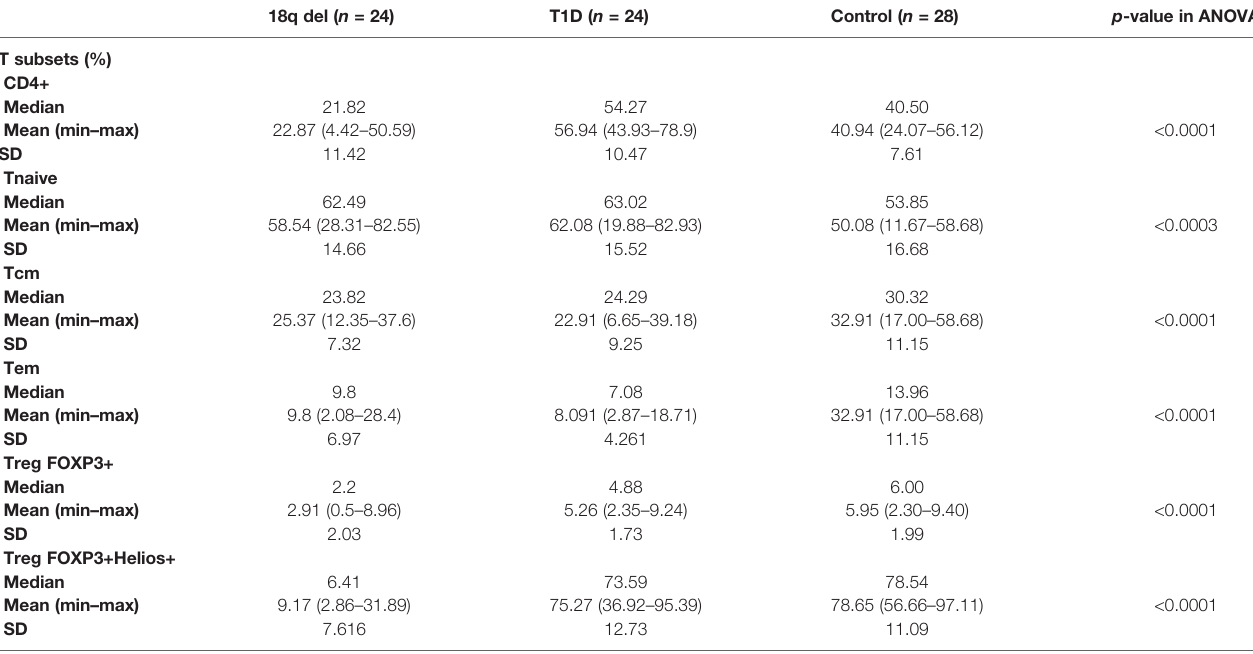
TABLE 4 | The proportion (%) of CD4+ lymphocytes in patients with 18q del, patients with T1D (control group), and 28 healthy controls. 18q del ( n = 24) T1D ( n =